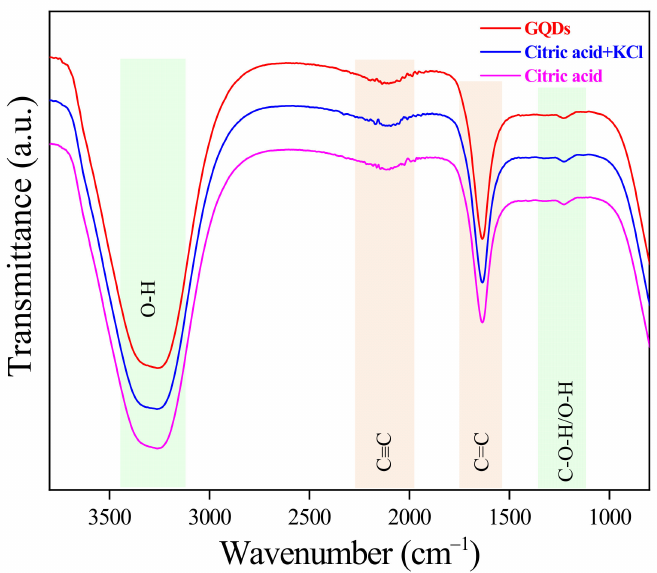
Figure 4. FTIR transmittance spectra of GQDs at different electrolyte